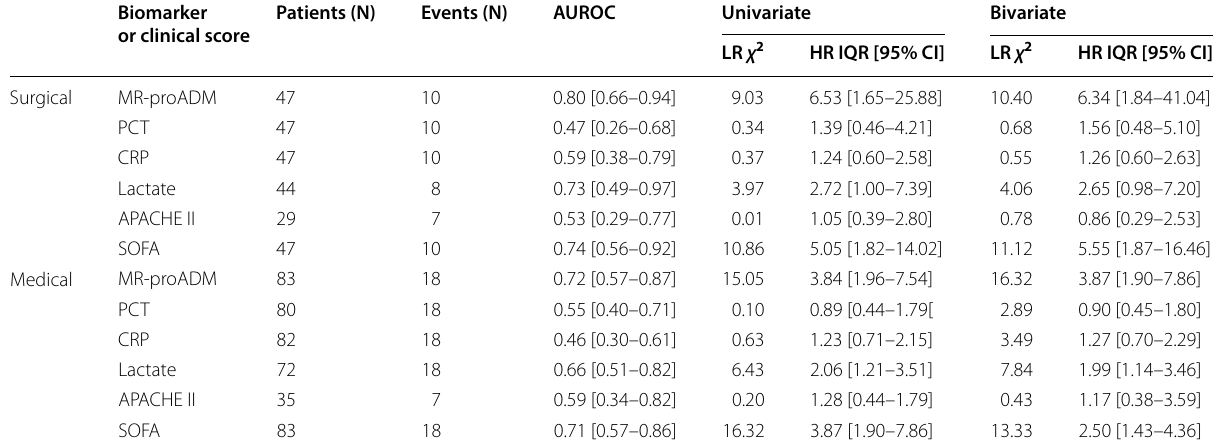
APACHE II Acute Physiological and Chronic Health Evaluation II score, AUROC area under the receiver operating characteristic curve, CI confidence interval, CRP C-reactive protein, HR hazard ratio, IQR interquartile range, LR likelihood ratio of the χ 2 test, MR - proADM mid-regional proadrenomedullin, N number, PCT procalcitonin, SOFA Sequential Organ Failure Assessment score